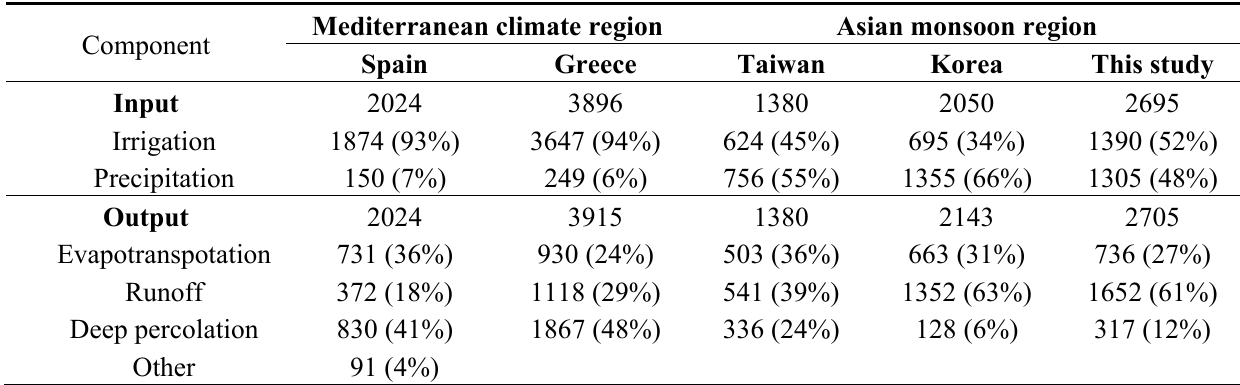
Table 10. Comparison of water budget components in paddy rice fields by climate